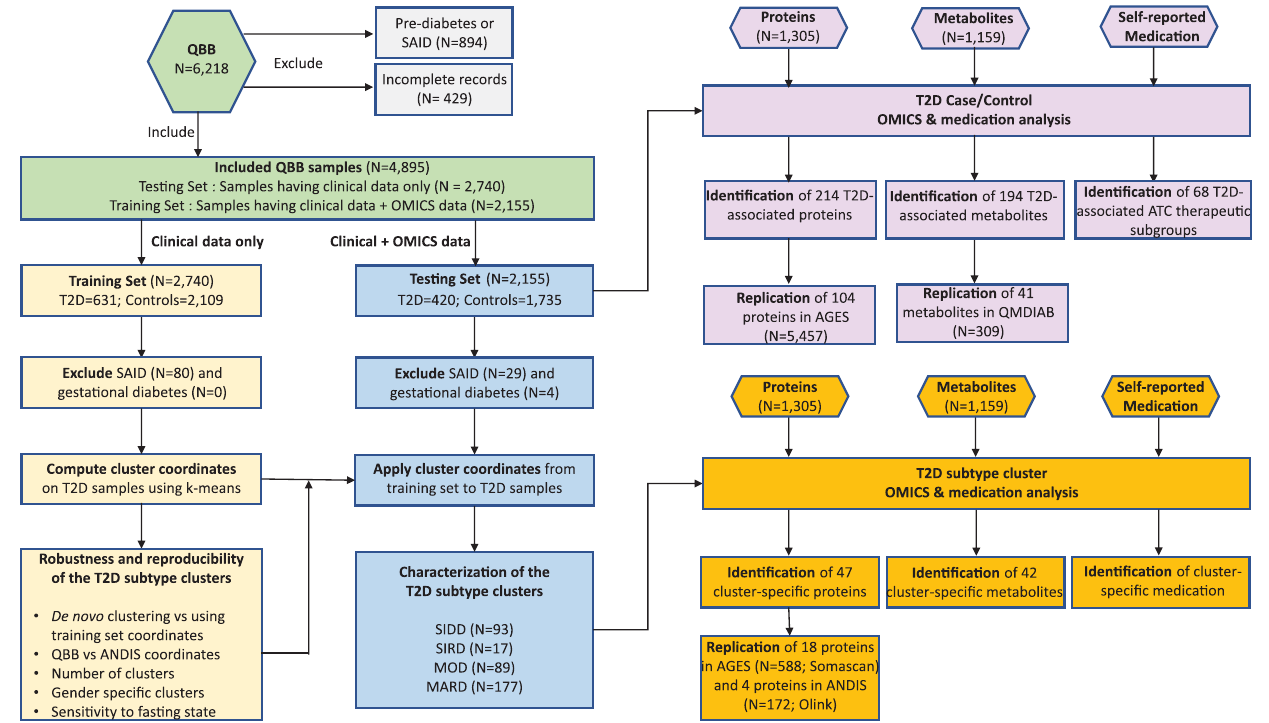
Fig. 1 | Study design. The study includes two main parts. The fi rst part consists of the identi fi cation of T2D subtypes in an Arab population by applying a clustering scheme from the ANDIS study, comparing the Arab clusters to the European clusters, and testing forvarious confounding factors.The second part includesthe omics(proteins and metabolites) and medication analysisin both the case/control